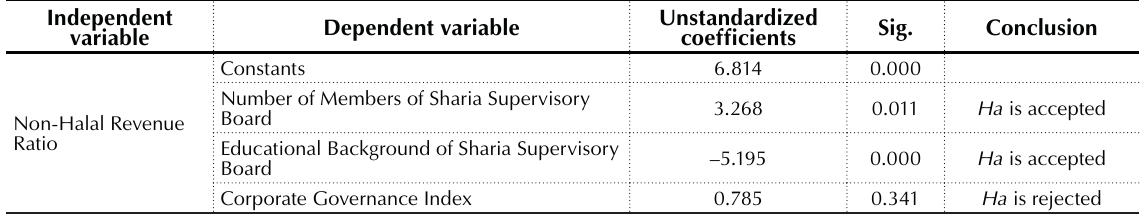
Table 5. Partial test result from Model